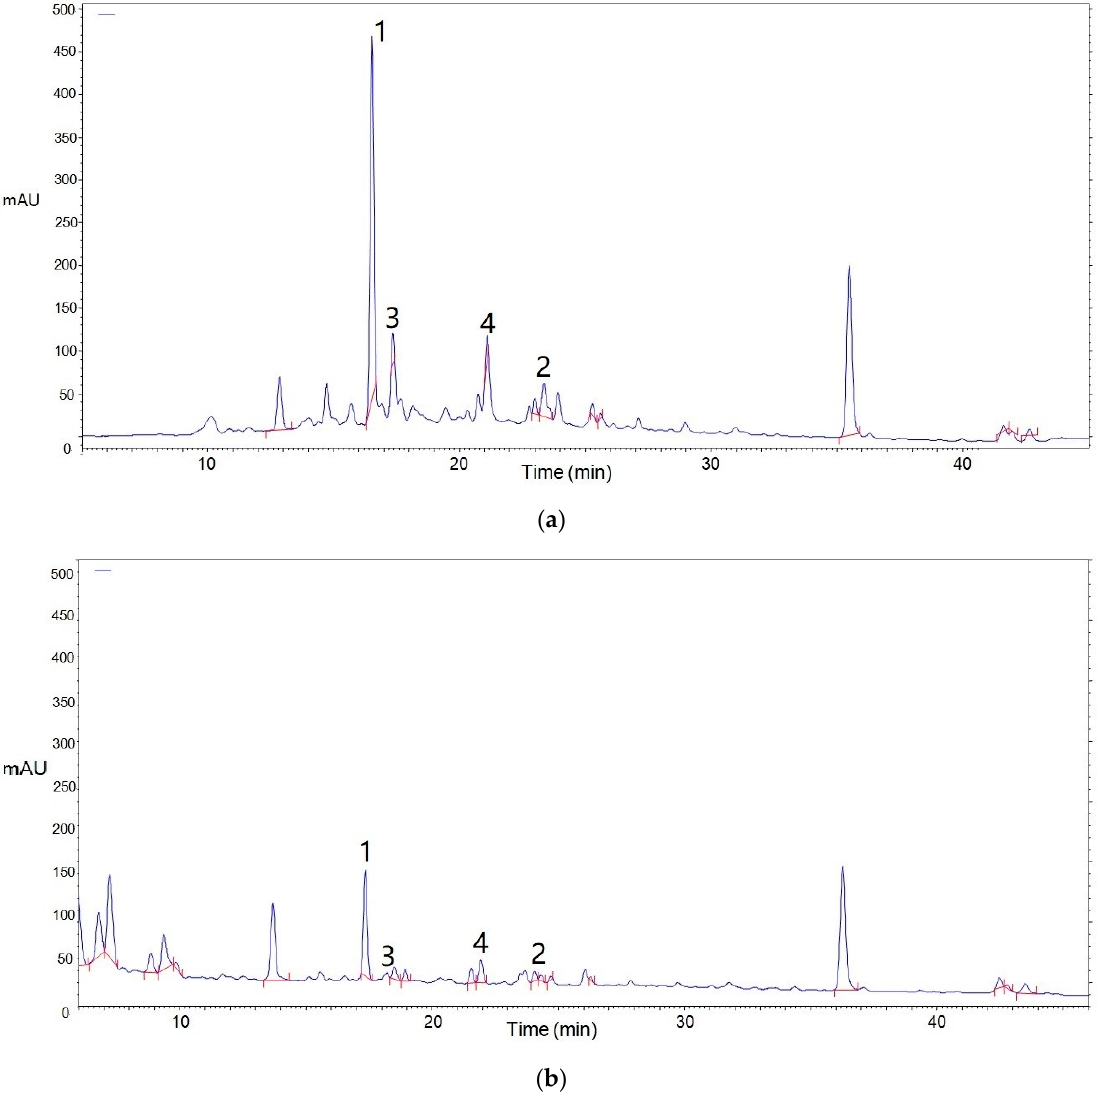
Figure 5. Composition of procyanidin oligomers in litchi pericarp before ( a ) and after ( b ) baked in cookies. Peaks 1–4 represented EC, A-3, A2, and A1, respectively.